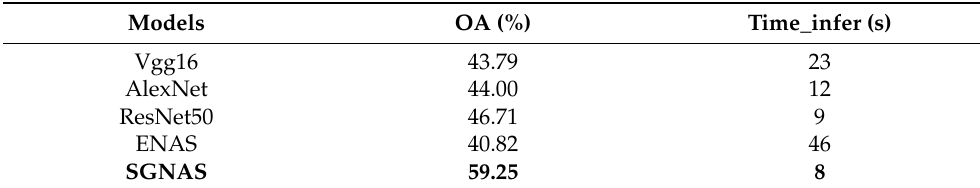
Table 1. Overall accuracy and inference time of cross-domain scene classification of different models on UCM → RSSCN7.